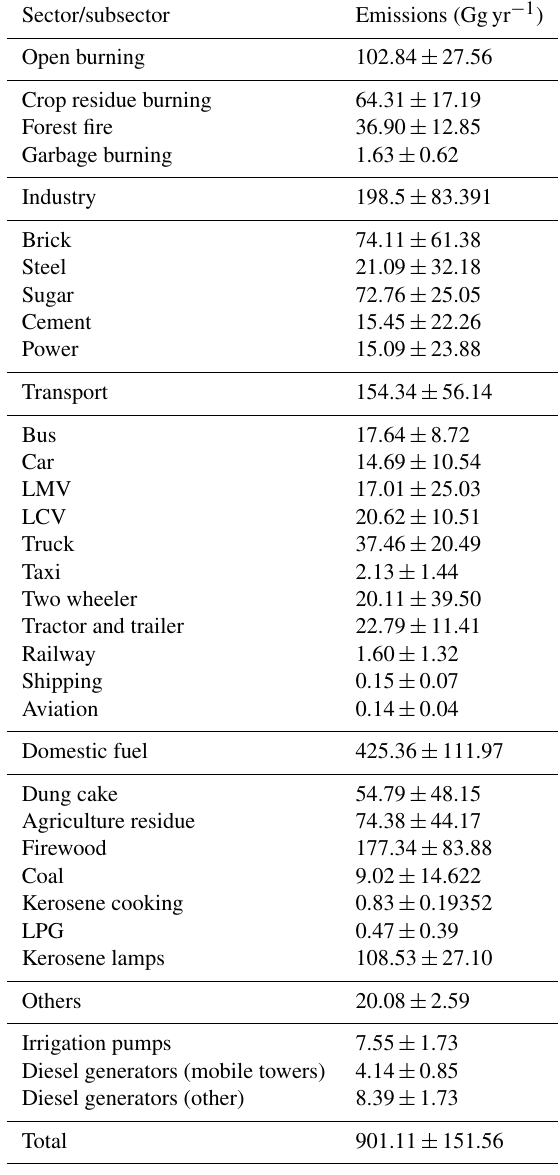
Table 3. Mean national emissions and standard